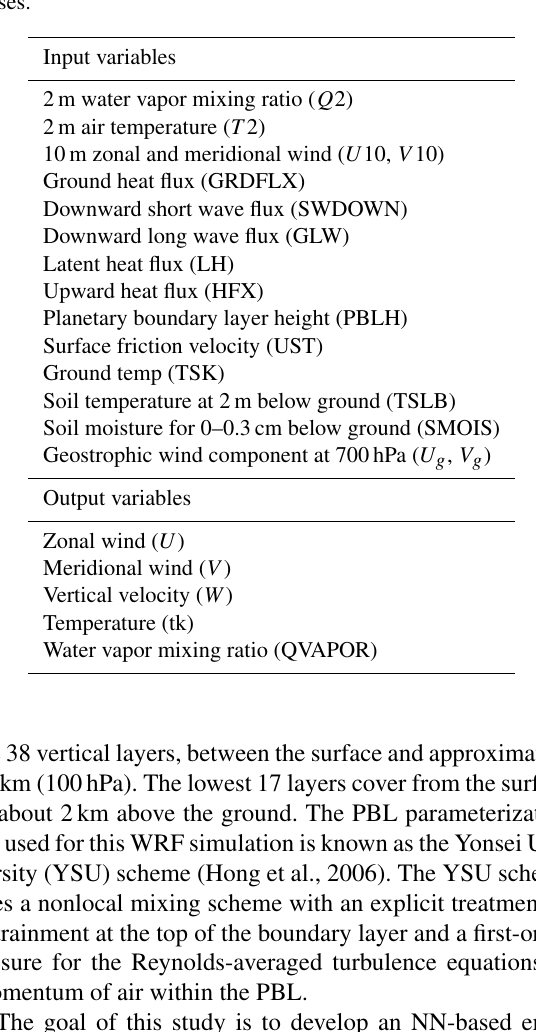
Table 1. Inputs and outputs for the DNNs developed in this study. The variable names from the WRF output are shown in the paren-